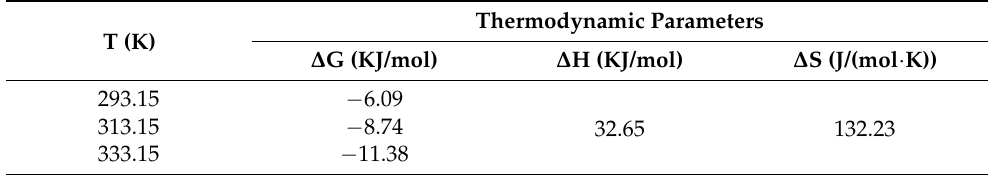
Table 6. Calculated thermodynamic parameters for toluene adsorption. T